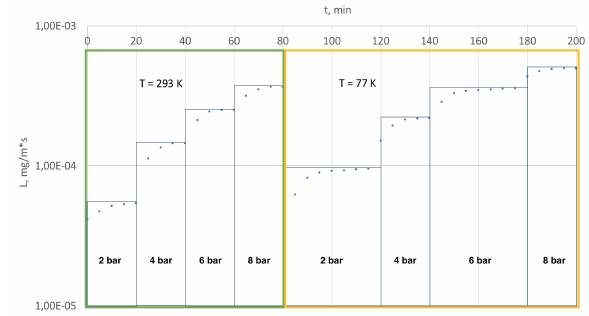
Figure 7: An example of stabilization of helium leakage from a flanged joint gasketed with expanded graphite.